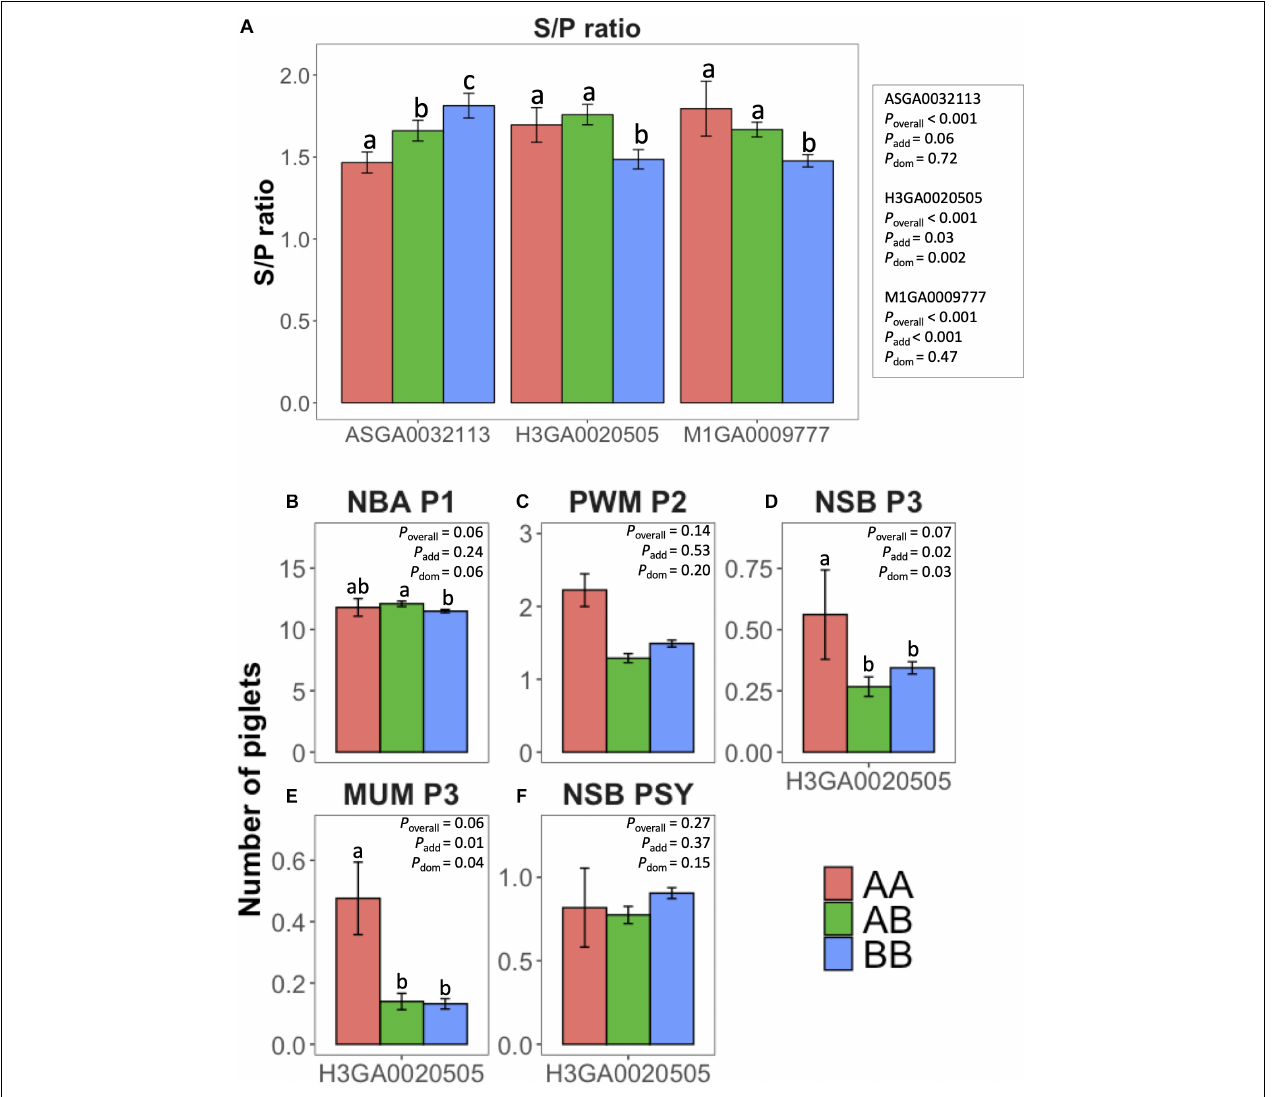
FIGURE 2 | Effect of selected single-nucleotide polymorphisms (SNPs) from univariate [antibody response (S/P ratio) to porcine reproductive and respiratory syndrome virus vaccination] and bivariate (farrowing performance) genome-wide association studies. y -axis represents least squares means for (A) S/P ratio, (B) number born alive at first parity (NBA P1), (C) pre-weaning mortality at second parity (PWM P2), (D) number of stillborn (NSB) at third parity (NSB P3), (E) number of piglets mummified at third parity (MUM P3), and (F) NSB per sow per year (NSB PSY). Colors represent the genotypes AA (coral), AB (green), and BB (blue) of the SNP evaluated: ASGA0032113, M1GA0009777, and H3GA0020505. Error bars represent standard errors. Different letters over the bars represent significant difference between the genotypes within a SNP. P -values for the overall F -test, additive effect, and dominance effect of each SNP are represented by P overall , P add , and P dom ,